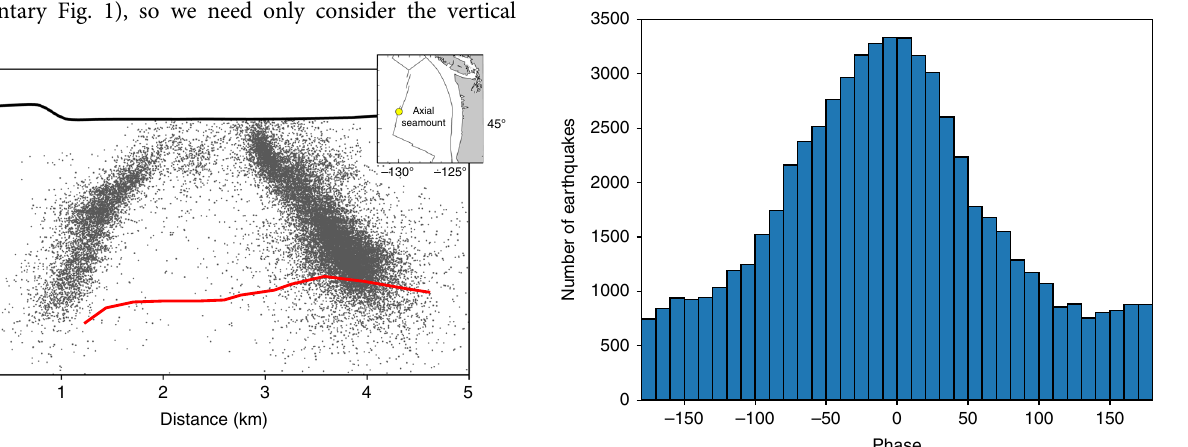
Fig. 1 Cross-section of seismicity at Axial Volcano. East – west cross-section of seismicity in 3 months preceding the 2015 eruption at Axial Volcano. Red curve is the roof of the axial magma chamber 15 . The bathymetry is from a compilation of latest cruises, the most recent in 2010 62 . Inset, location map for Axial Volcano